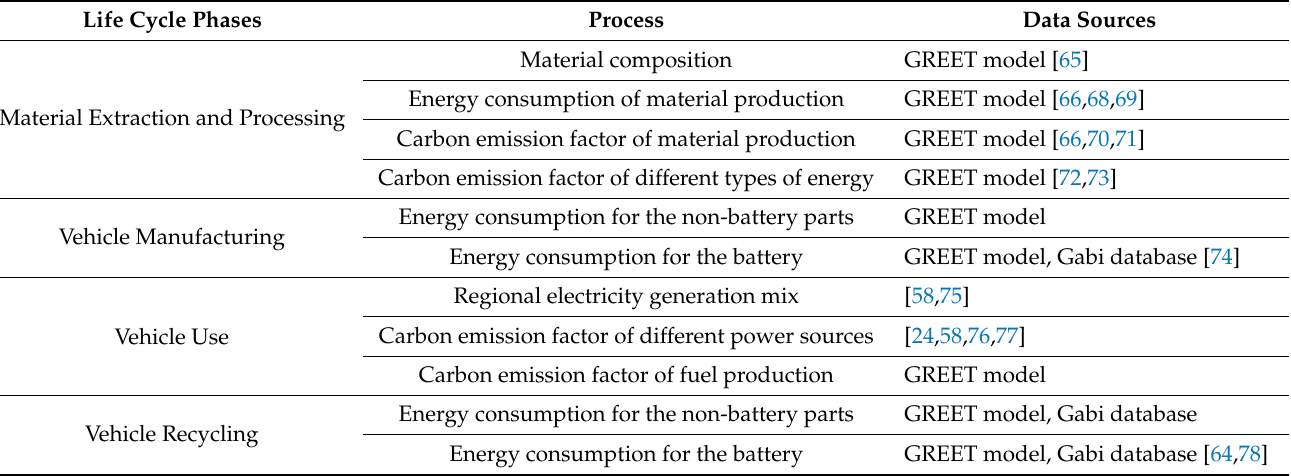
Table 3. Data sources of the life cycle